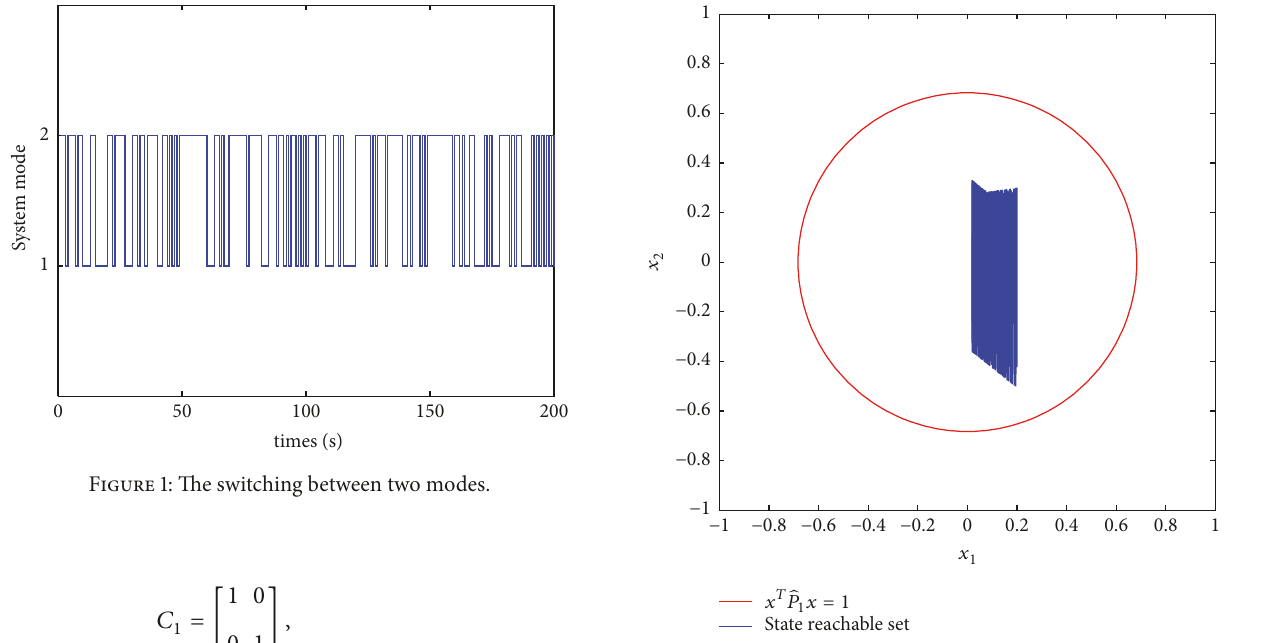
Figure 2: The state reachable set R 𝑥 and the bounding ball B